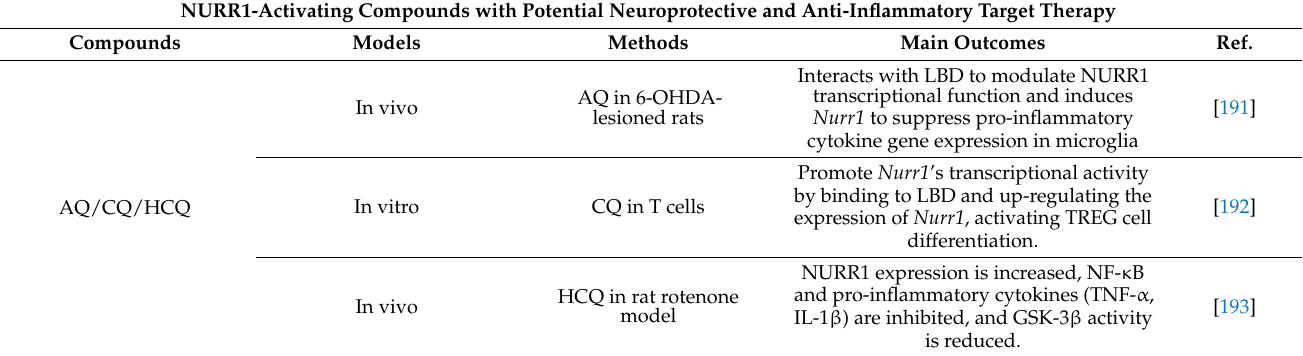
Table 2. A summary of the potential neuroprotective and anti-inflammatory therapy roles of NURR1. NURR1-Activating Compounds with Potential Neuroprotective and Anti-Inflammatory Target Therapy Compounds Models Methods Main